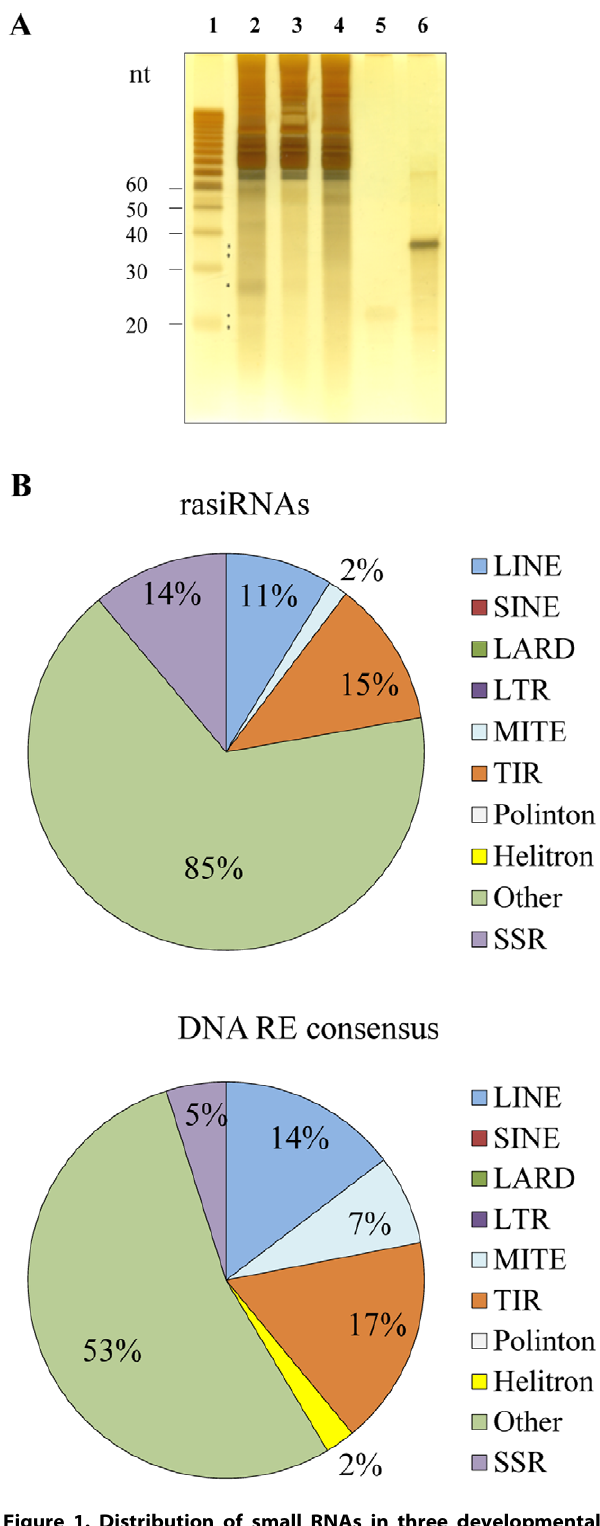
Figure 1. Distribution of small RNAs in three developmental stages of S.frugiperda and annotation of mapped rasiRNAs. A) Total RNAs (5 m g) from three developmental stages of S. frugiperda were loaded onto a 17% polyacrylamide gel containing 7 M urea and stained with silver after electrophoretic separation. Molecular sizes (in nucleotides) are shown on the left of the figure. Some discrete bands of small RNAs are labeled with asterisks. 1) Decade small RNA ladder,